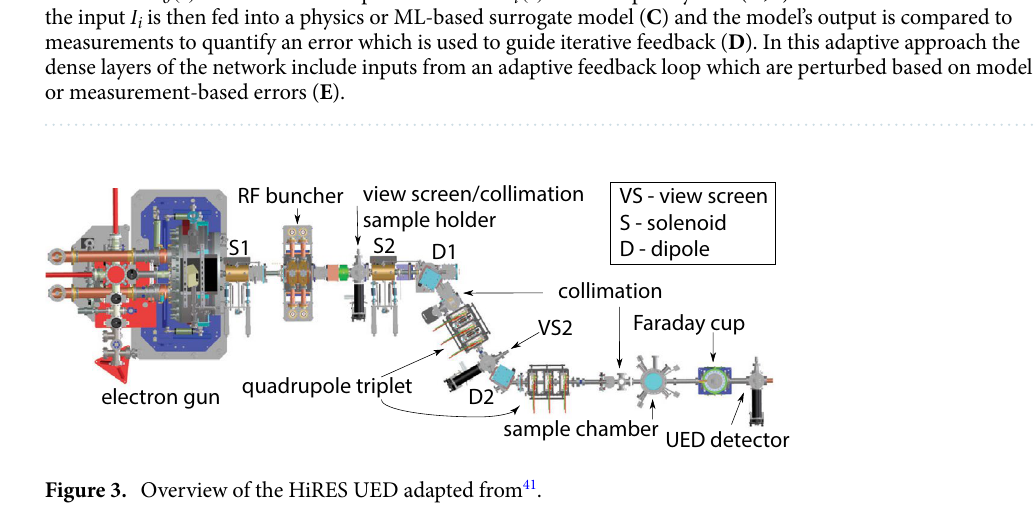
Figure 3. Overview of the HiRES UED adapted from 41